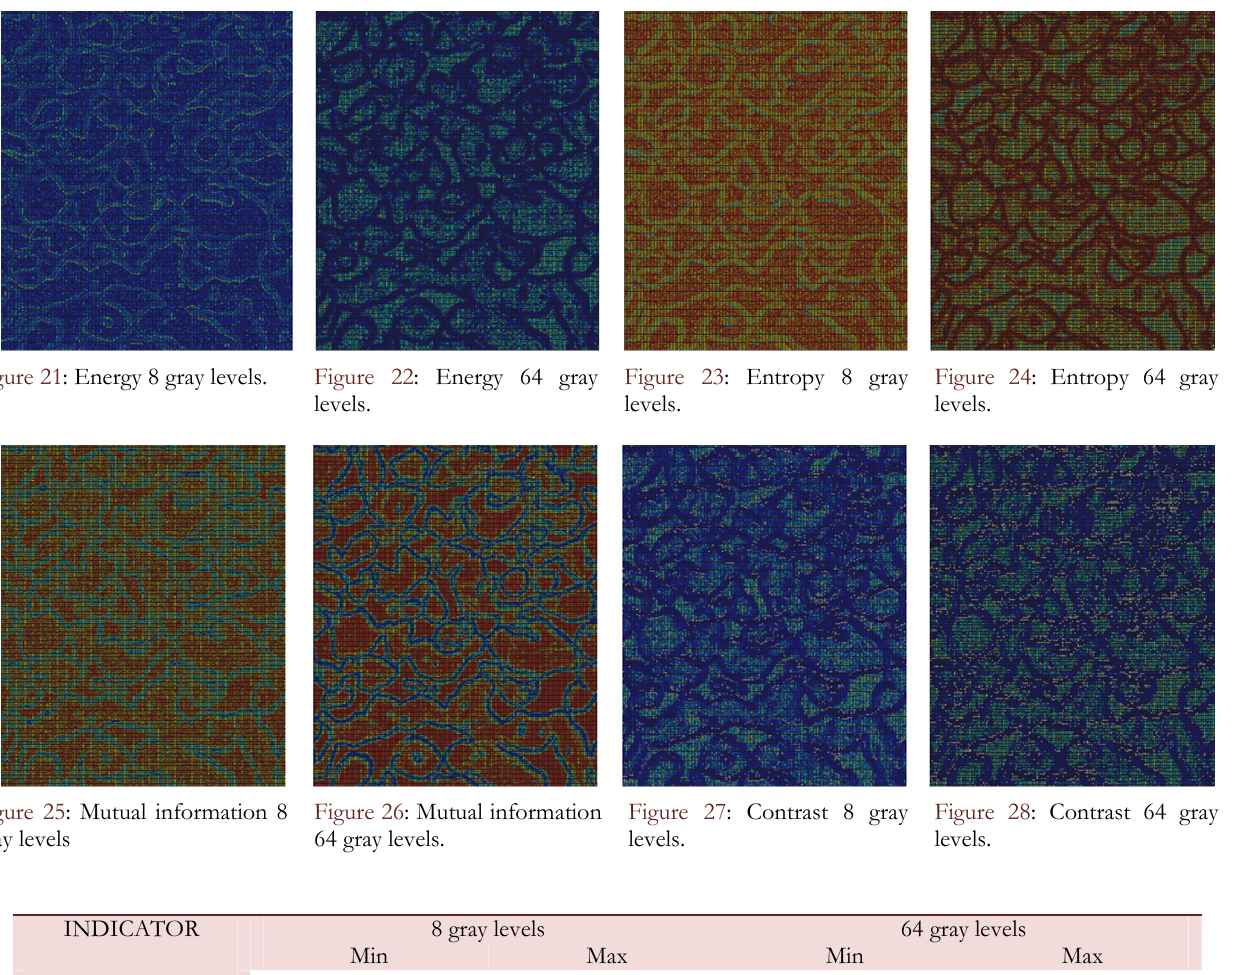
Table 2: Minimum and maximum values assumed by the